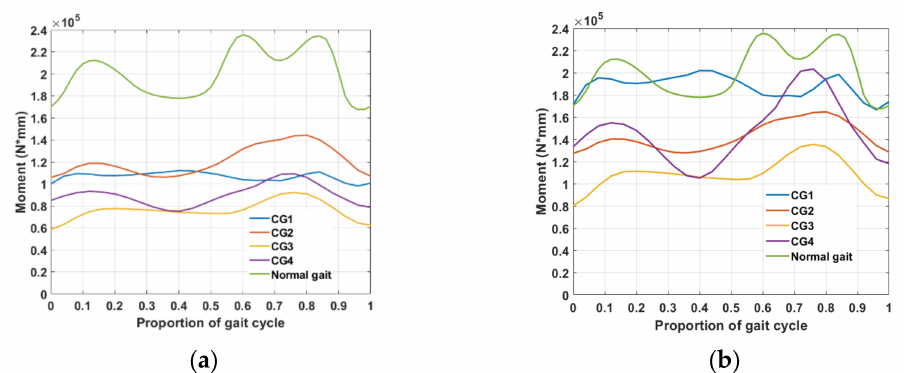
Figure 9. Graphs of the moments generated in the knee throughout the gait cycle, using: ( a ) 20 k Nmm/deg torsion springs and ( b ) 30 k Nmm/deg torsion springs. Torsion springs at 30 k Nmm/deg significantly reduced moments in the stance phase in all crouch gaits except for CG 1 (blue curve) in Figure 9b. The peak moments trended toward the unimpaired (normal) gait curve in CG2 (red curve) and CG4 (purple curve). CG2 showed peak stance phase moments at 12% with 140,307.0 Nmm, and 36% at 127,834.0. The peak moments in CG4 occurred at 12% at 154,915.8 Nmm, and at 40%, at 105,117.9 Nmm. All crouch gaits, regardless of spring stiffness, require improvement in the swing phase of the gait cycle. A significant adjustment of peak moments and their occurrences in the stance phase of the gait cycle across all gaits are noticeable with both the 20 k Nmm/deg and 30 k Nmm/deg torsion springs when compared to each uncorrected crouch